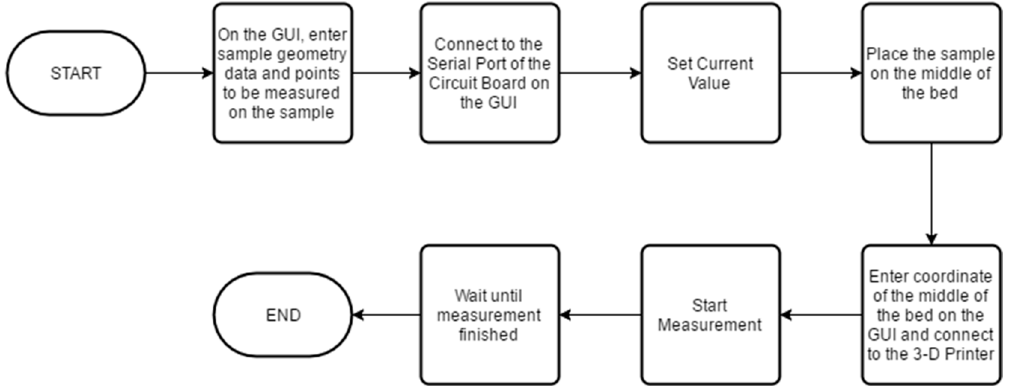
Figure 1. Measurement process flowchart.